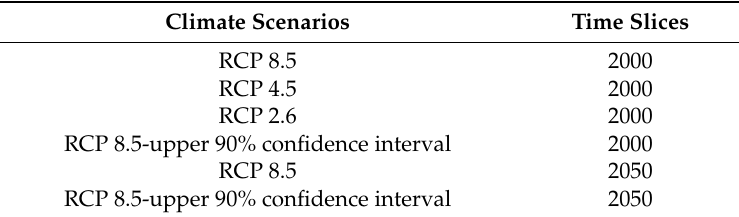
Table 3. Summary of analysis